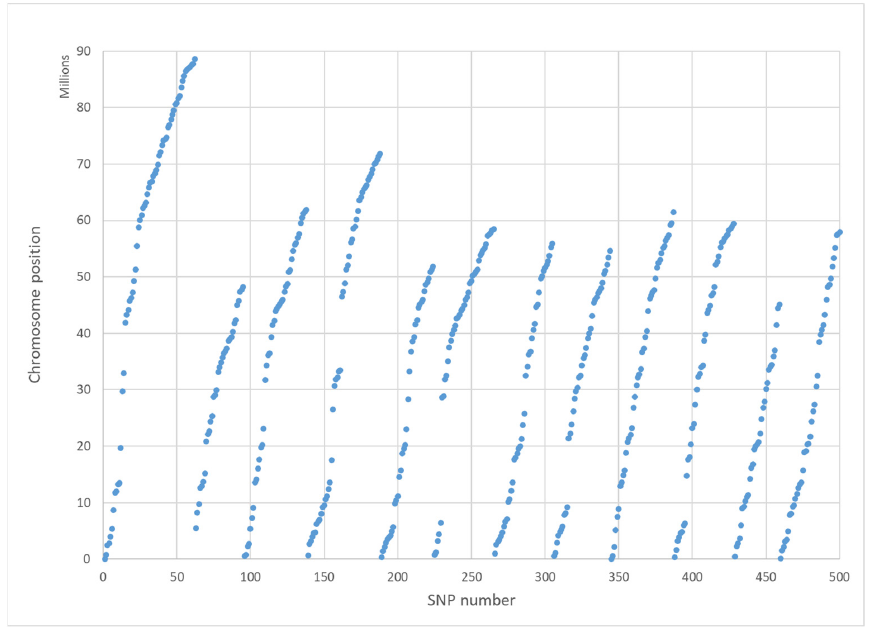
Figure 1. The positions of the final selection of 500 SNPs for SeqSNP, relative to the known potato genomic map.